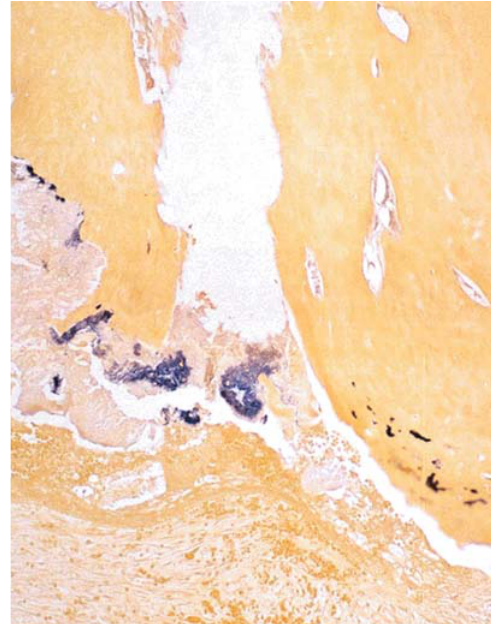
FIGURE 7a- Amplification of Figure 7. Microorganisms in cementum lacunae, Brown & Brenn - 1000X